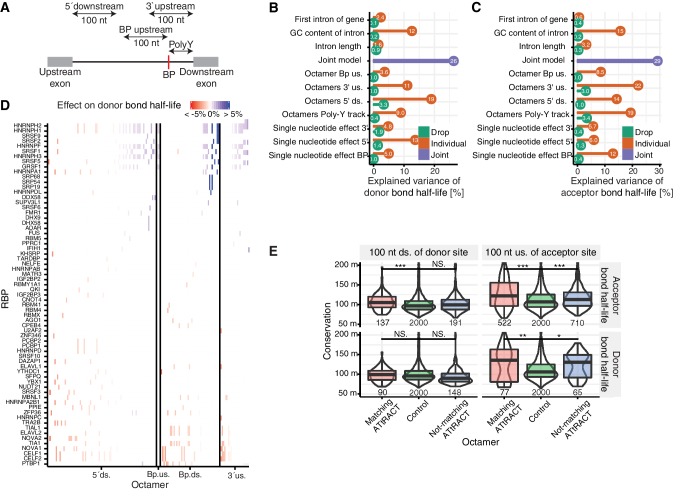
Precursor RNA sequences contributions to splicing kinetics.(A) Schematic representation of the regions used for the octamer search (BP = branchpoint, polyY = polyY track). In case of short intron, the regions 5ʹ downstream, 3ʹ upstream, and BP upstream were cropped to not extend into the exonic regions. Poly-Y track was defined as the region from the branchpoint up to the acceptor site. (B–C) Proportion of variance explained by the joint model (purple) for log-transformed donor (B) or acceptor (C) bond half-lives, as well as proportion of variance explained by individual features (orange) and drop of the proportion of variance explained when individual features are removed from the joint model (green). 5´ds = 5´downstream, 3´us = 3´upstream. (D) Effect on donor bond half-life of octamers matching to RNA-binding proteins (RBP, rows) motifs identified using the ATtRACT database. Each column represents one octamer; the color depicts strength and direction of the effect. (E) Distribution of the phylogenetic conservation score (PhastCons 100-way) of random octamers (green), significant octamers matching (red) and not matching (blue) the ATtRACT database of RNA-binding motifs, estimated by region (column) and model (row). Black bars represent the median values for each group. Lower and upper boxes are the first and third quartile, respectively. Stars above boxes depict pairwise significance levels by Wilcoxon signed rank test. (D based on Supplementary file 5).